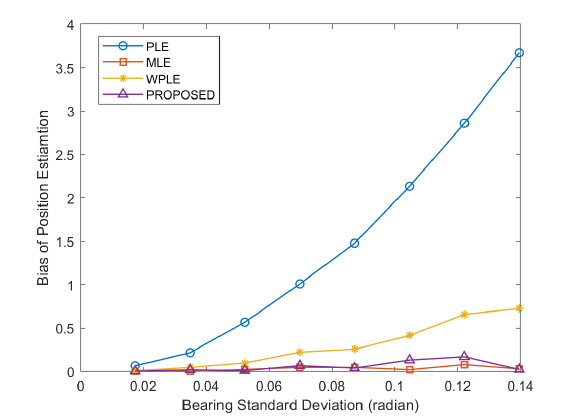
Figure 7. Bias of position estimation versus bearing standard